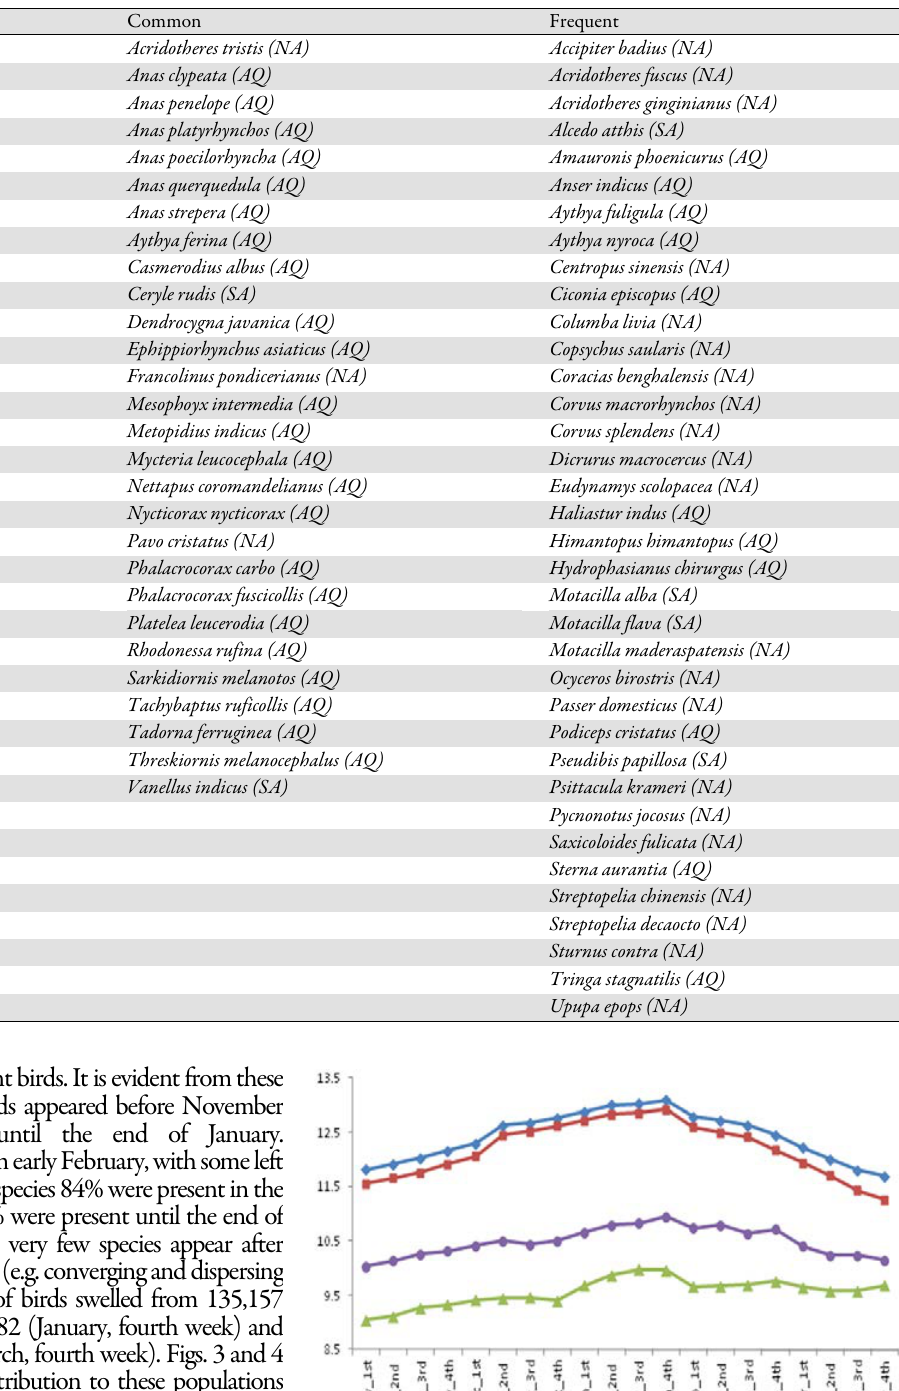
Table 4. List of bird species of Abundant (10-12), Common (7-9) and Frequent (4-6) occurrence across the protected wetlands of Uttar Pradesh;